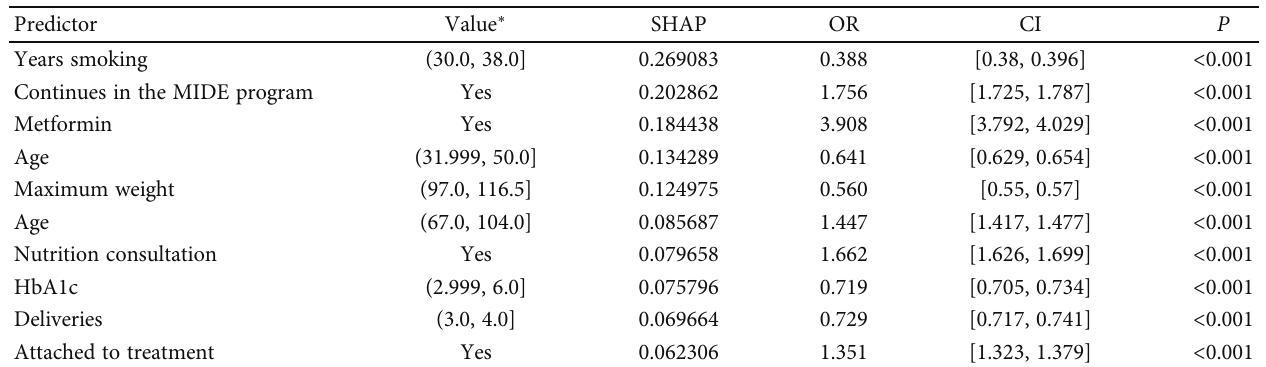
Table 2: Summary of the ten most important predictors for the model of chronic complications in patients with diabetes.